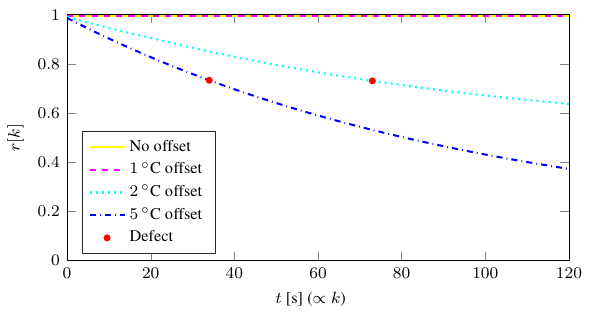
Figure 11. Reliability and detected defects for offset sensor faults. Results are shown for constant offsets between 1 and 5 ◦ C. Detected defects are marked by a red dot.